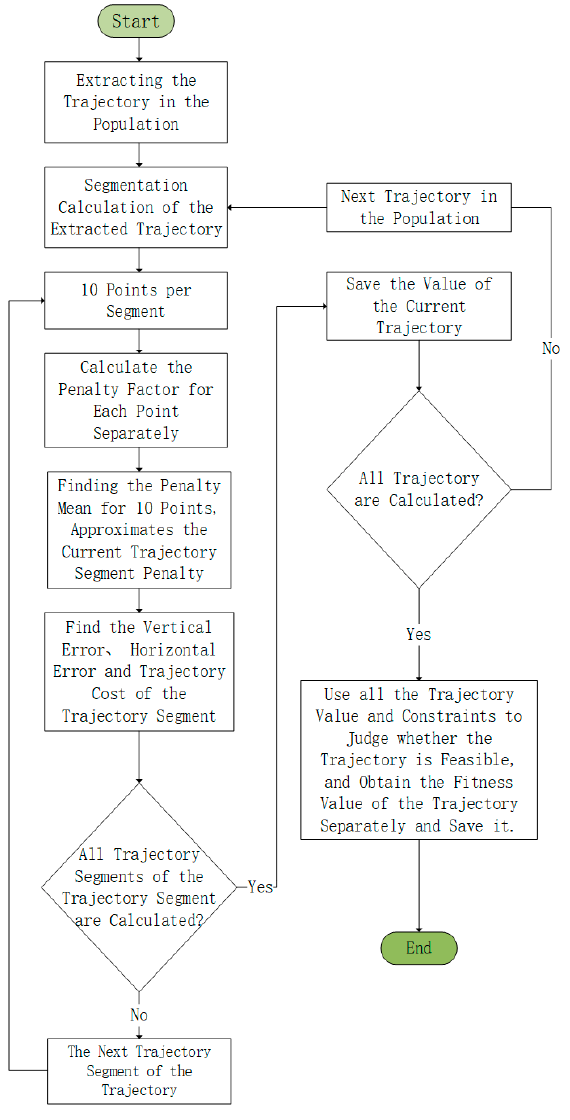
Figure 6. Solution process of trajectory fitness value.